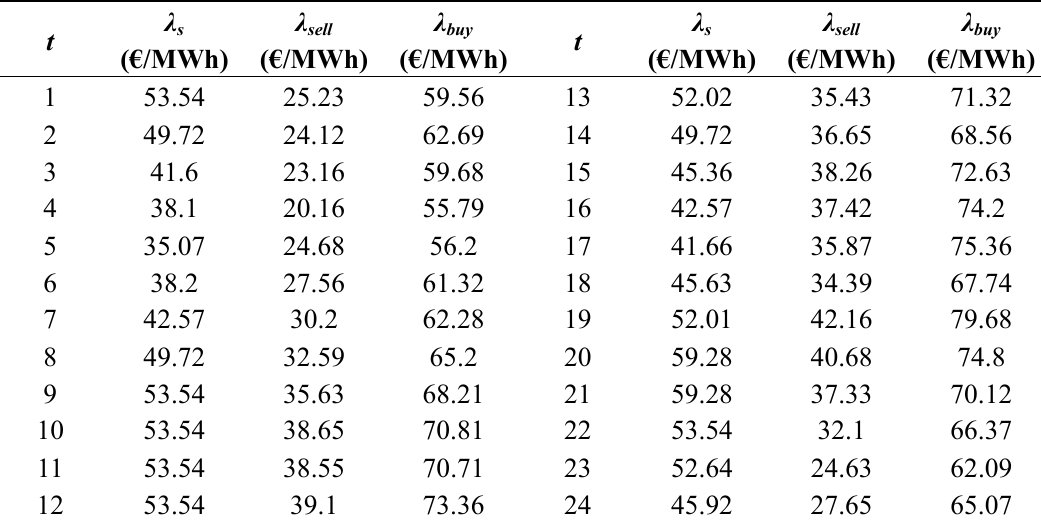
Table 3. Hourly day-ahead market price and imbalance prices.